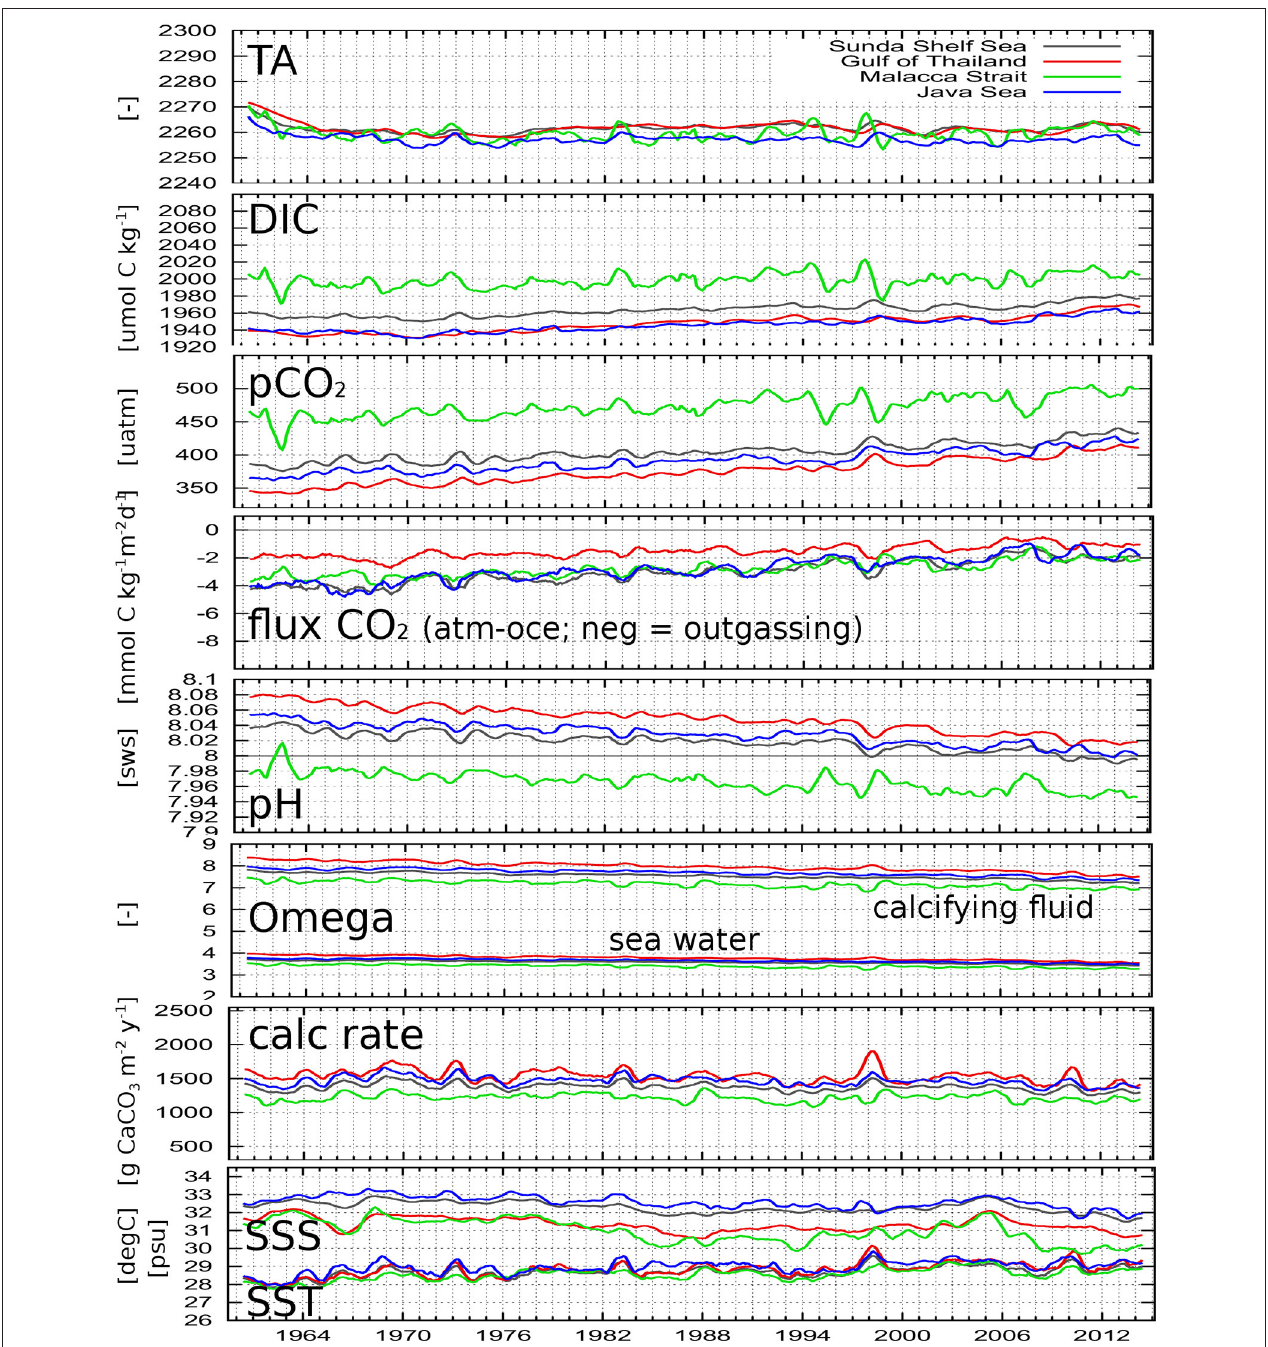
FIGURE 7 | Simulated parameters as spatially averaged yearly running means for the entire Sunda Shelf Sea (gray), Gulf of Thailand (red), Malacca Strait (green), and the Java Sea (blue). pH is in seawater scale; “Omega” is the saturation state of aragonite; “calc rate” means aragonite calcification rate. Locations of regions are shown in Figure 2C